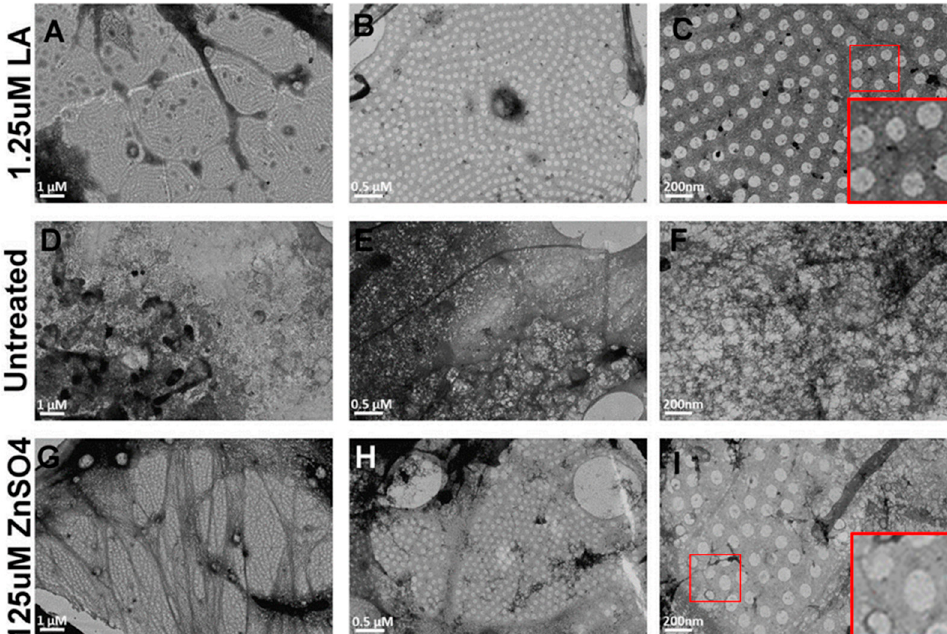
Figure 4. Zinc-induced fenestrae formation was examined by TEM. Fenestrae formation induced by LA ( A – C ) was used as a positive control for these observations. In untreated cells, there was some spontaneous fenestrae formation; however, these lacked uniformity and diaphragm organization ( D – F ). As compared to LA-treated cells, zinc induced comparatively smaller sieve plates without major cytoskeletal rearrangements ( G , H ). However, zinc-induced fenestrae were uniform and exhibited typical morphology, including diaphragm formation ( I ), like those induced by LA ( C ). (Scale bar, ( A , D , G ) = 1 micron; ( B , E , H ) = 0.5 micron; ( C , F , H ) = 200 nm). The size of fenestrae was assessed using ImageJ from the TEM images taken at 12,000 ×